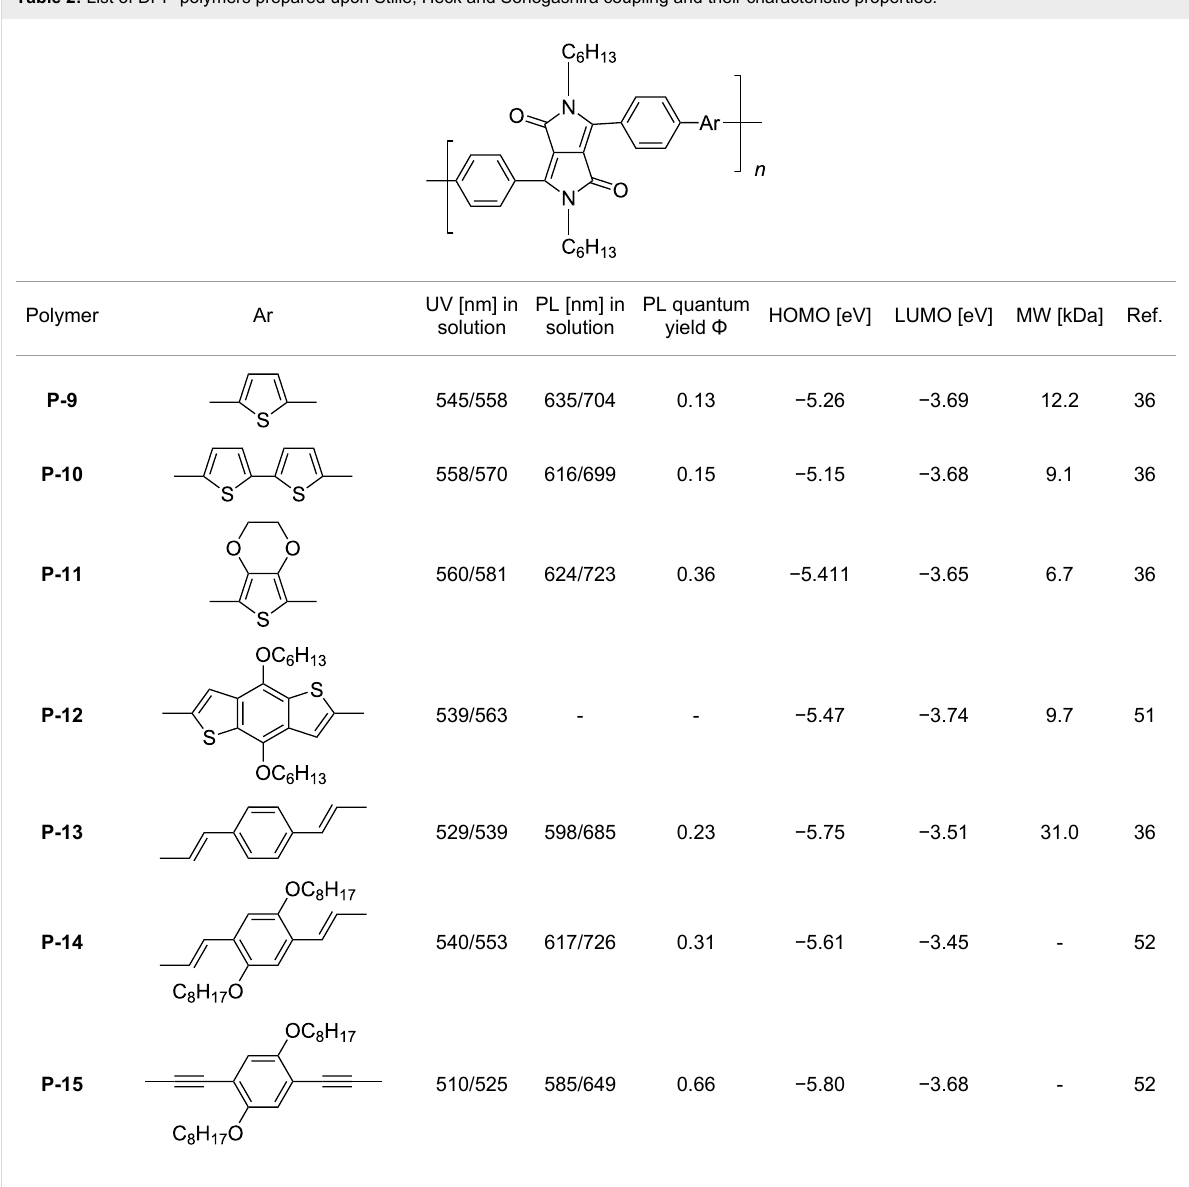
Table 2: List of DPP-polymers prepared upon Stille, Heck and Sonogashira coupling and their characteristic properties.